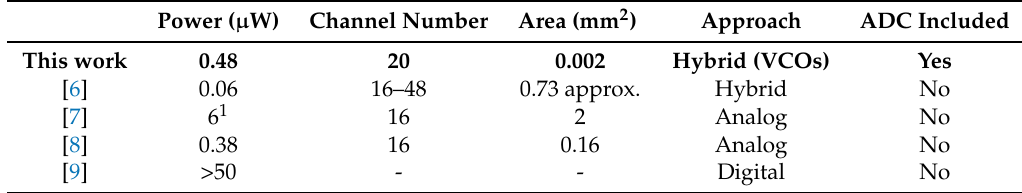
Table 2. Comparison to equivalent